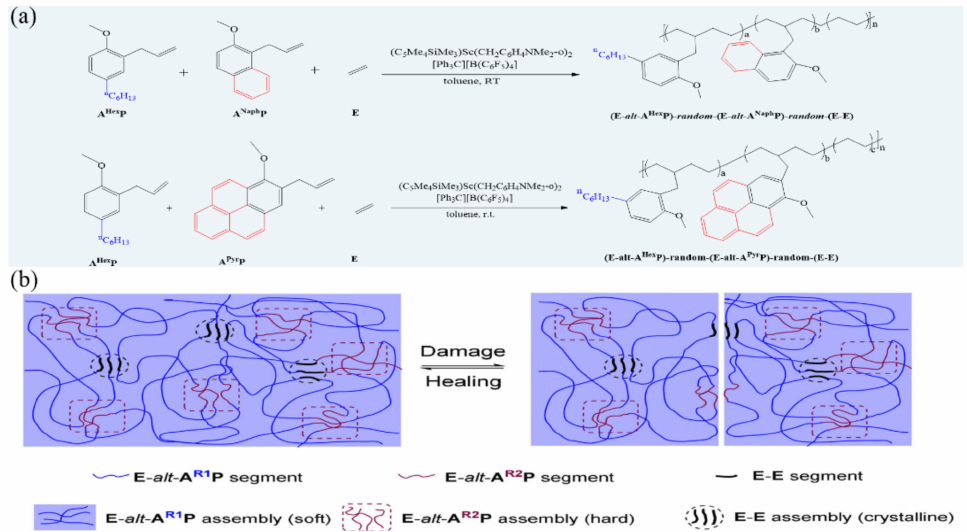
Figure 9. ( a ) Terpolymerization of ethylene (E), hexylanisyl propylene (AHexP), and methoxynaph- thyl propylene (ANaphP)/methoxypyrenyl propylene (APyrP) by a half-sandwich scandium catalyst. ( b ) Representation of multiphase morphology of a E-AR1P-AR2P terpolymer and its self-healing mechanism. E = ethylene, A R1 P = hexylanisyl propylene (AHexP), A R2 P = methoxynaphthyl propy- lene (ANaphP), or methoxypyrenyl propylene (APyrP). Reproduced with permission from [112]. Copyright (2021) Wiley-VCH